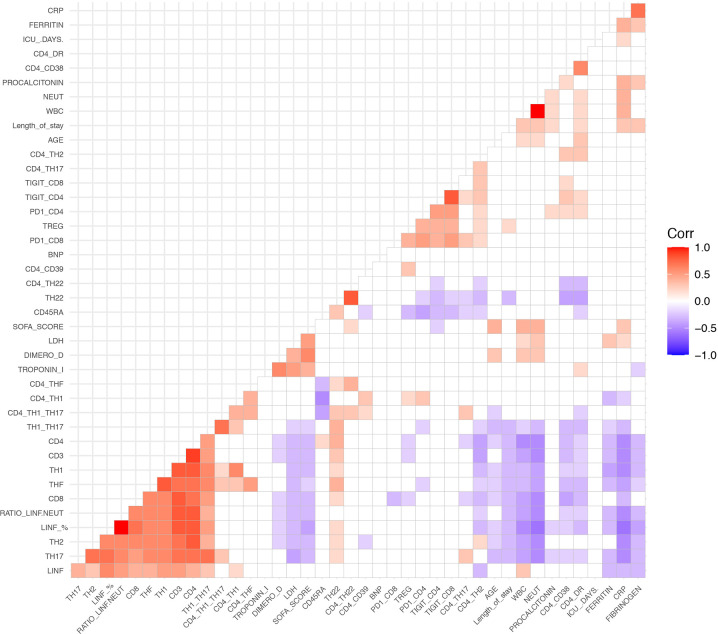
Spearman correlation heatmap of all measured cell populations, biochemical parameters and clinical parameters. Red indicates a positive correlation and blue represent a negative correlation. Non-significant correlations are left blank.